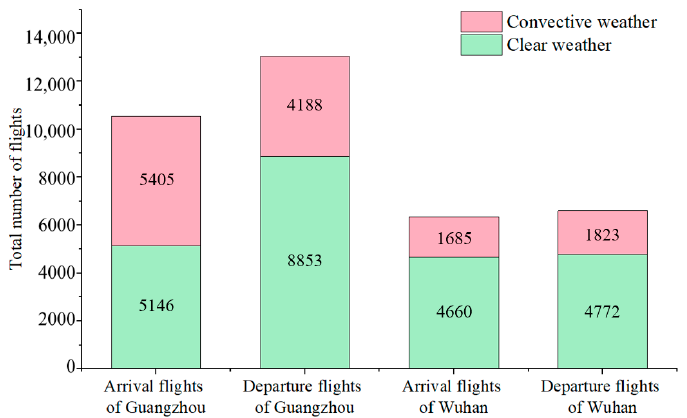
Figure 6. The total number of flights from 3 to 31 August 2018. The flight plan includes the flight number, registration number, aircraft type, departure airport, arrival airport, flight plan route, and other information. It is used to filter flights in the designated terminal